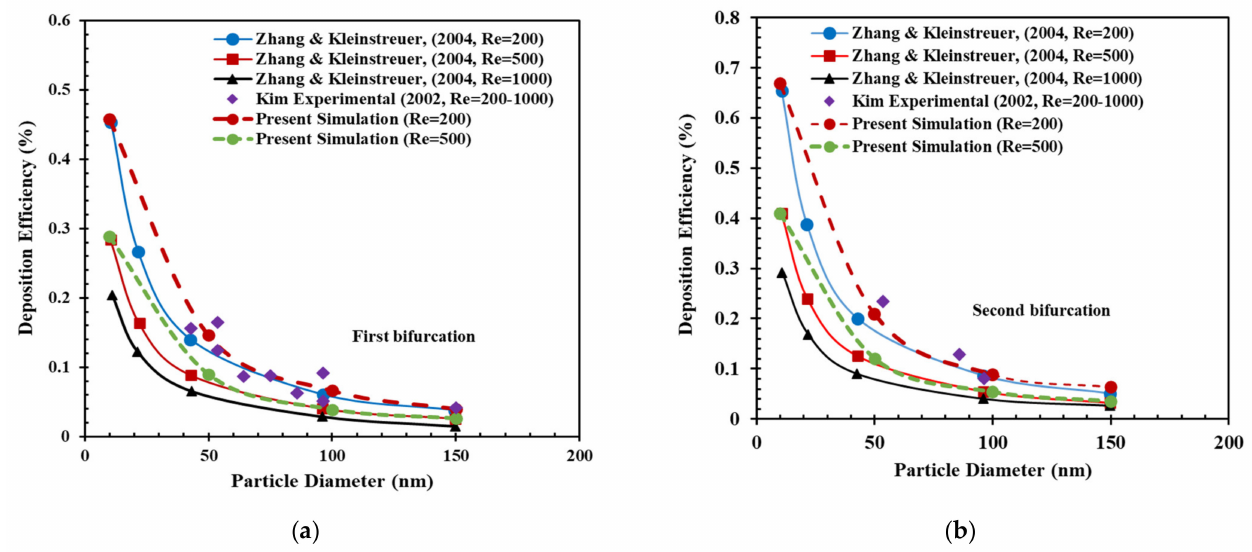
Figure 4. Comparison between present simulation results at the generation G3–G5 model and results from literature [7,41] ( a ) for the first bifurcation area; and ( b ) for the second bifurcation